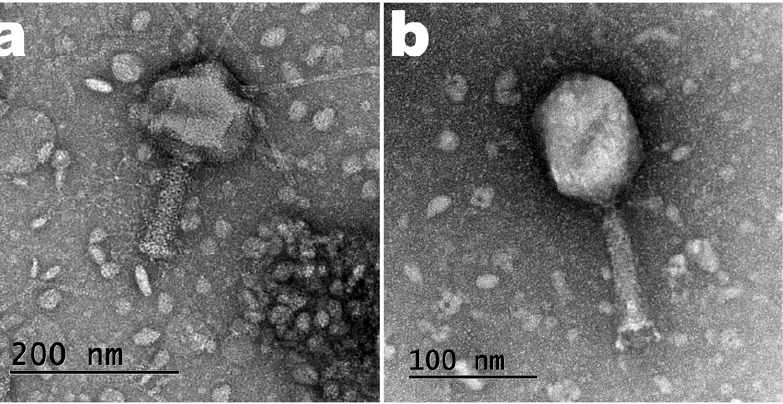
Figure 10. Negative-staining TEM photomicrographs of phages vB_EcoM_Uniso11 ( a ) and vB_EcoM_Uniso21 ( b ).